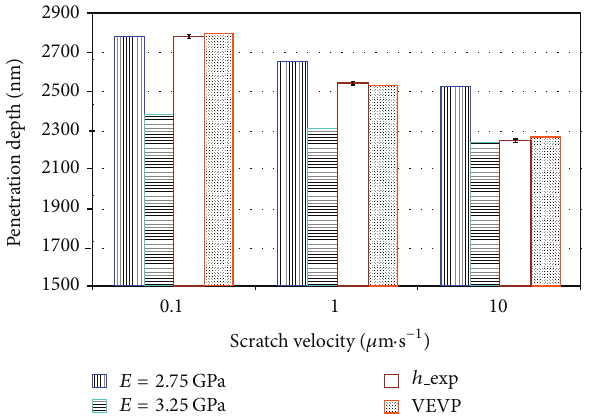
Figure 17: Comparison of experimental results ( ℎ exp) and numer- ical results (elastic-viscoplastic and viscoelastic-viscoplastic) for = 80 mN. The data denoted by 𝐸 = 2.75 GPa (resp., 𝐸 = 𝐹 𝑛 3.25 GPa) are those calculated with the elastic-viscoplastic model in using a Young modulus of 2.75 GPa (resp., 3.25 GPa). The data denoted VEVP corresponds to the viscoelastic-viscoplastic model.